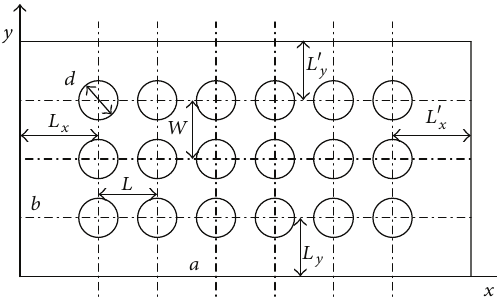
Figure 7: Distribution of dimple bionic nonsmooth surface.